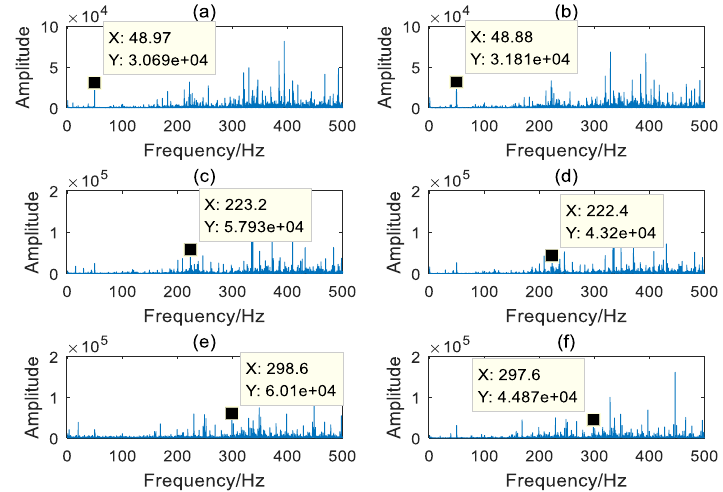
Figure 8. The spectrums of vibration signal under different speed conditions: ( a ) Healthy PG under 20% rated speed; ( b ) Sun gear pitting fault PG under 20% rated speed; ( c ) Healthy PG under 30% rated speed; ( d ) Sun gear pitting fault PG under 30% rated speed; ( e ) Healthy PG under 40% rated speed; ( f ) Sun gear pitting fault PG under 40% rated speed.